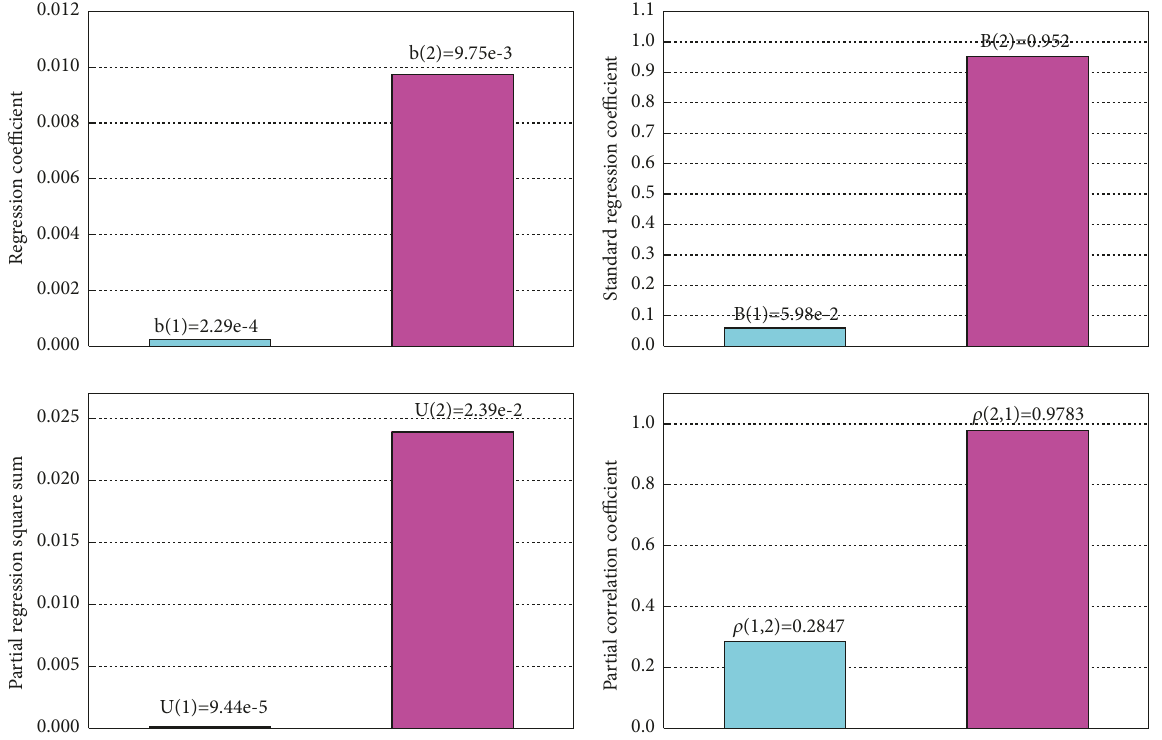
Figure 15: Regression analysis coefficient of equation